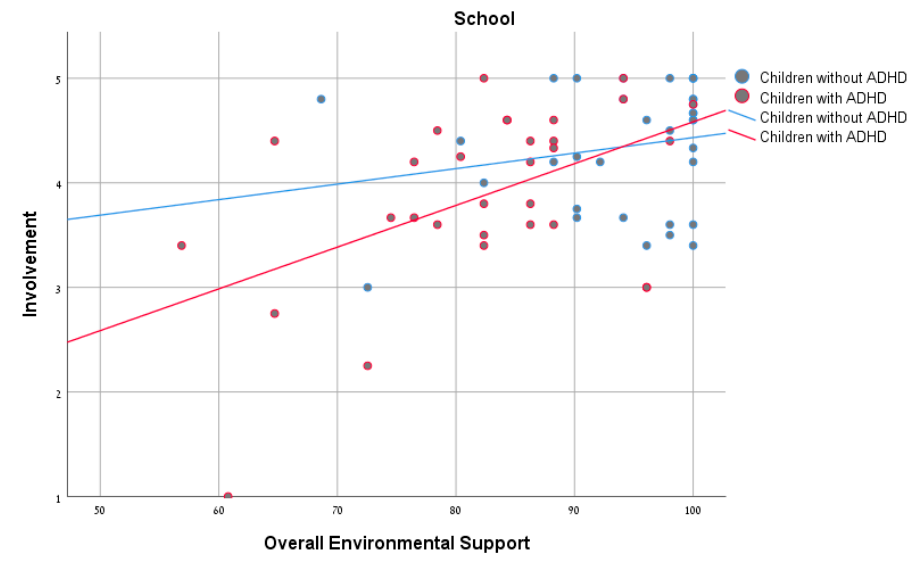
Figure 2. Correlations between overall environmental support and involvement among children with and without ADHD in the school environment.